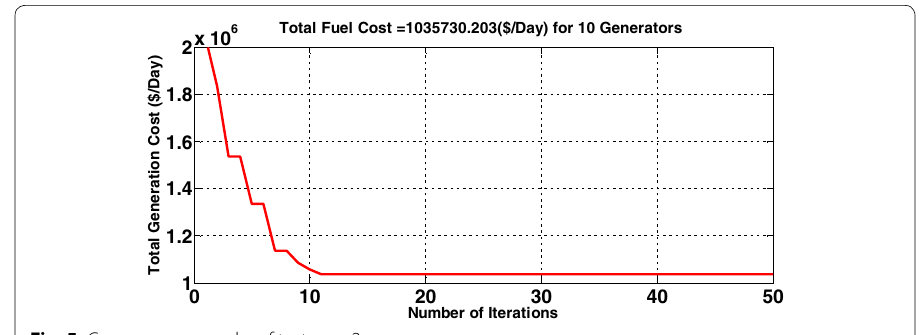
Fig. 5 Convergence graphs of test case